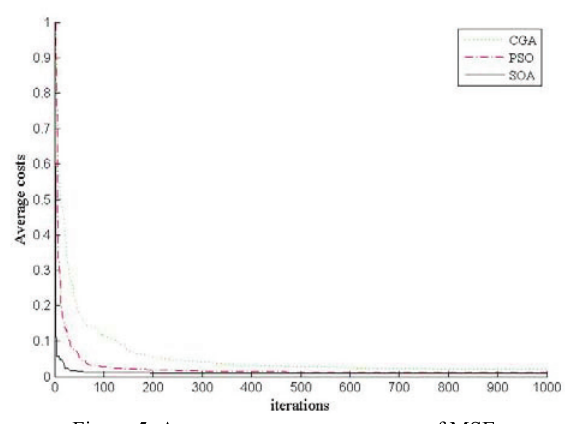
Figure 5. Average convergence curves of MSE